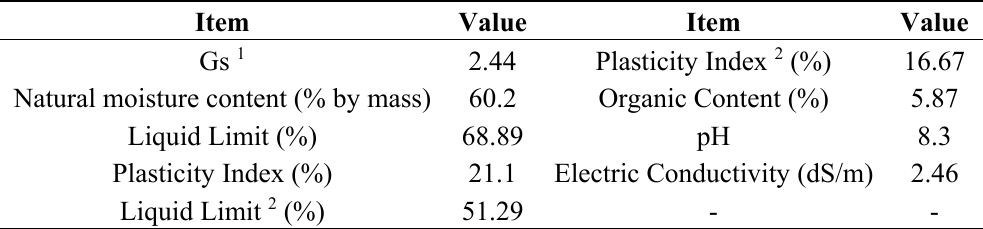
Table 1. Physical and chemical properties of organic marine clayey soil.